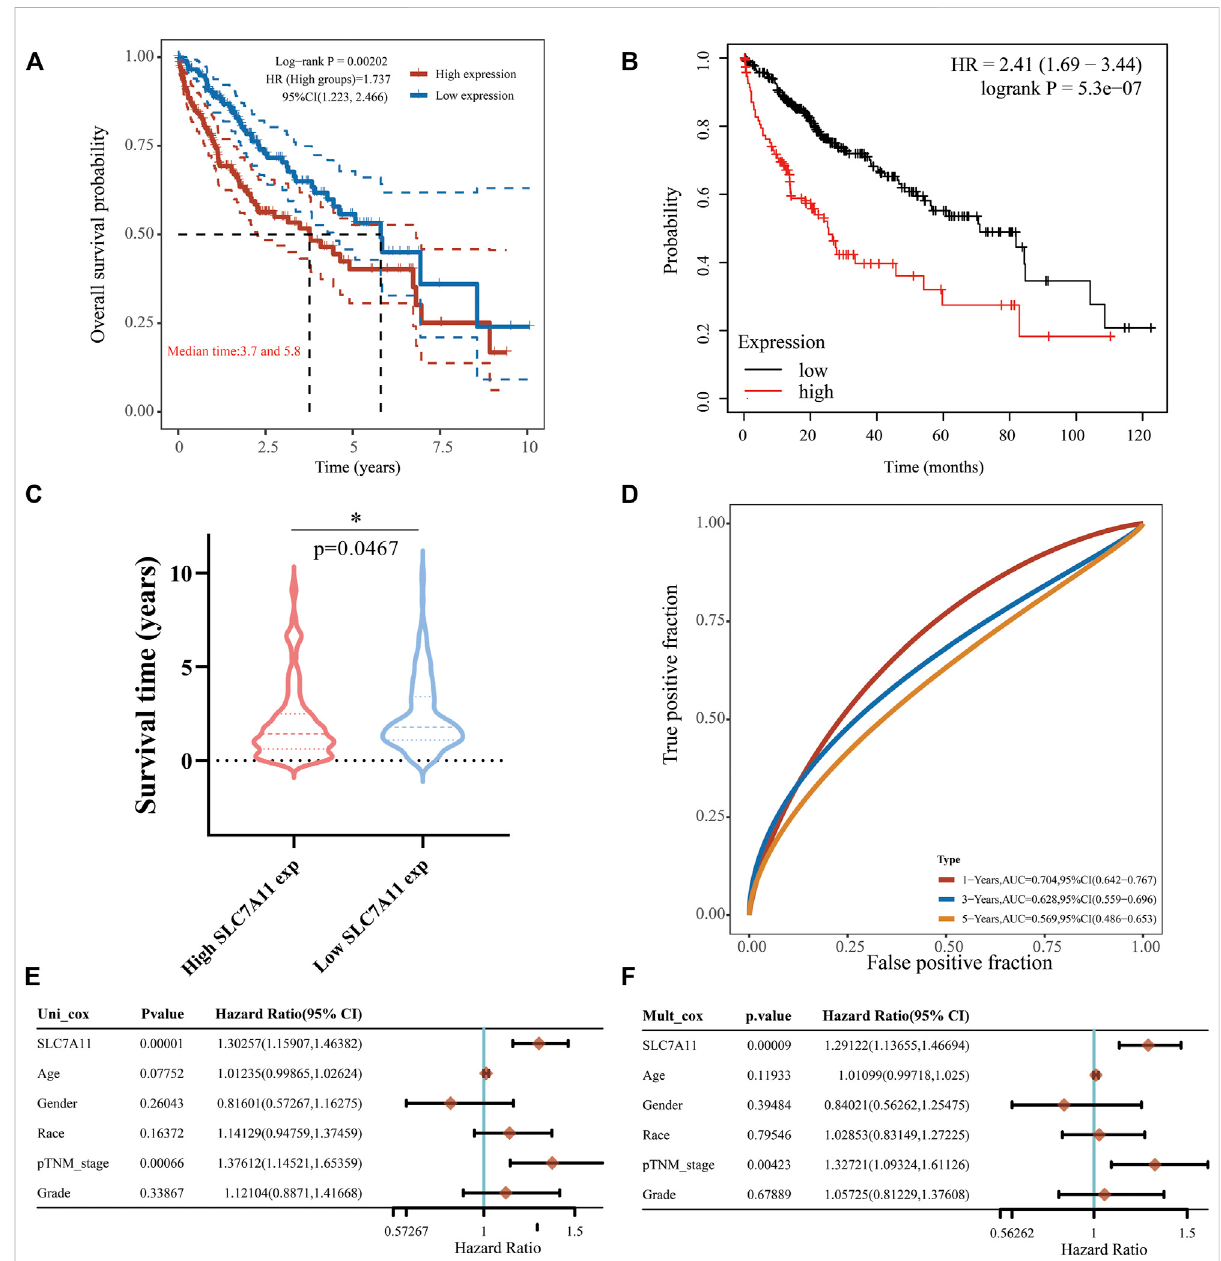
FIGURE 5 Effect of SLC7A11 expression difference on LIHC prognosis. (A) KM analysis for high and low SLC7A11 groups based on TCGA source data and the KM Plotter website (B,C) Differences in survival time between high- and low-SLC7A11 expression. (D) 1-, 3-, and 5-years survival prediction reliability of SLC7A11 as a prognostic factor. (E,F) Forest plots of univariate and multivariate Cox analyses for SLC7A11 and other clinical traits. * p <